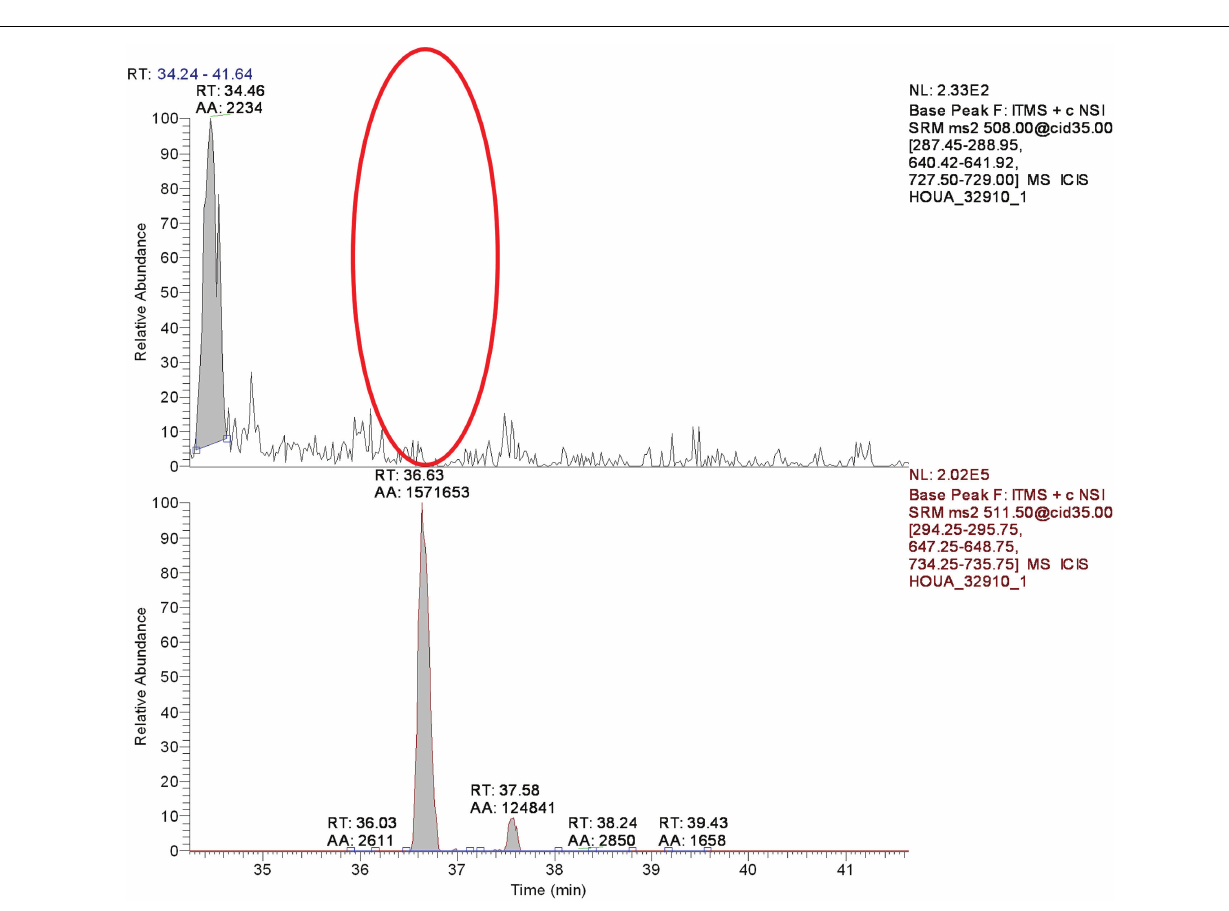
FIGURE 11 | Detection of the diagnostic MISHELR peptide of PSPHL in HOUA endometrial cancer cell lysate. Top panel. Red oval indicates the area where the peptide should be detected, its absence indicating no PSPHL protein in this extract. Bottom shows the recombinant peptide when spiked in the extract.